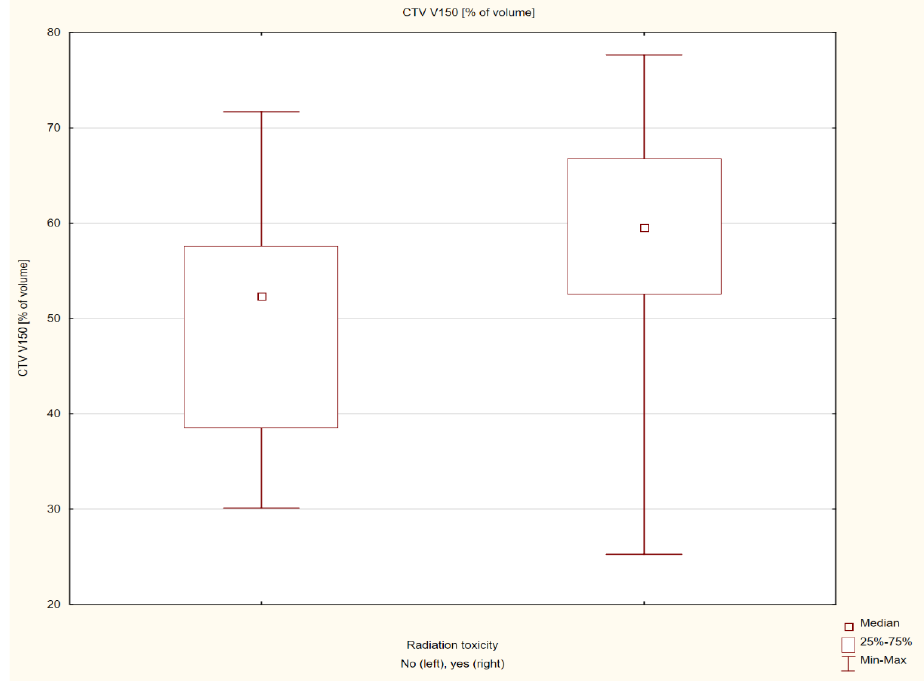
Figure 5. Analysis of the influence of the mean skin volume receiving a dose of 150% on the severity of post-radiation reaction.